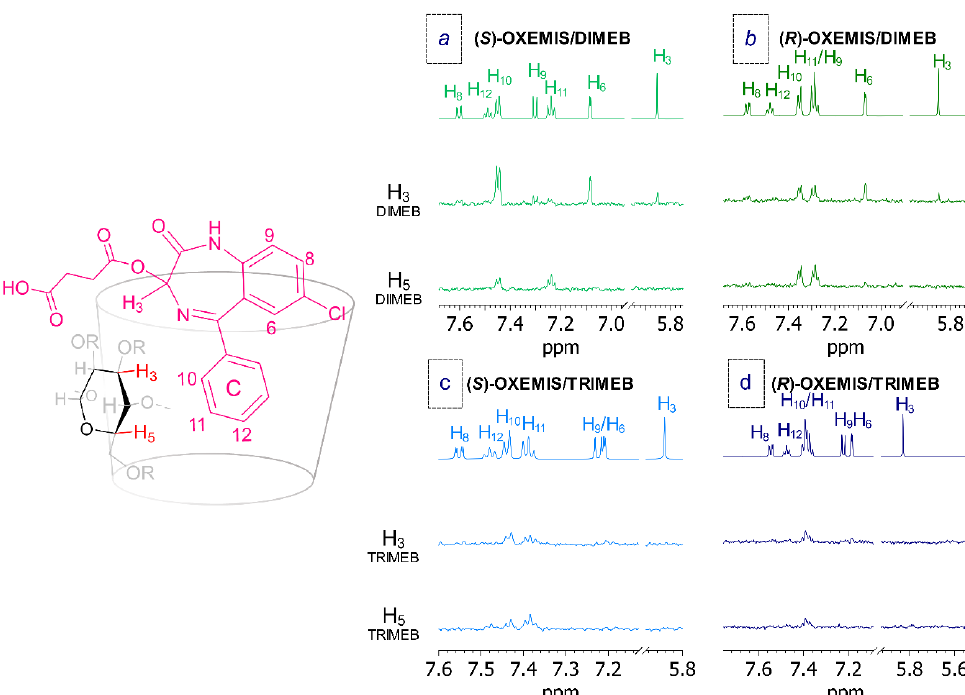
Figure 7. 1 H NMR (600 MHz, K 2 HPO 4 /D 2 O 50 mM, 25 °C) and 1D ROESY spectra (H 3 and H 5 protons) of cyclodextrins for: ( a ) ( S )-OXEMIS/DIMEB (1:2), ( b ) ( R )-OXEMIS/DIMEB (1:2), ( c ) ( S )-OXEMIS/TRIMEB (1:2), and ( d ) ( R )-OXEMIS/TRIMEB (1:2).